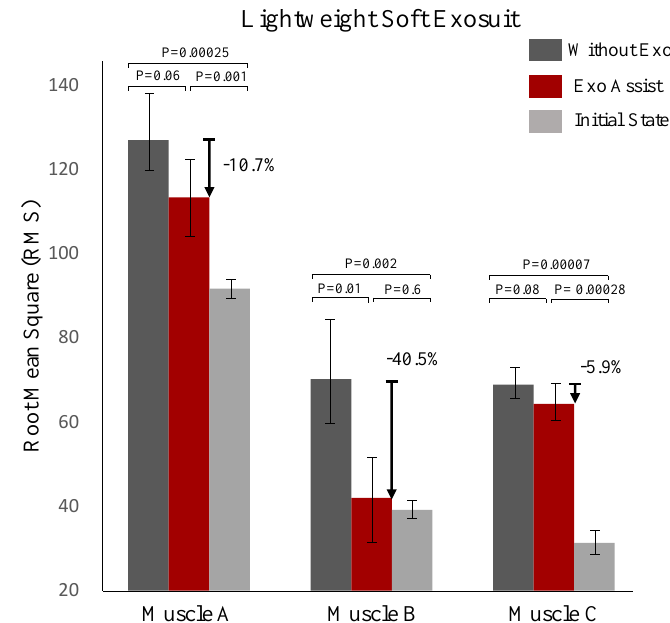
Figure 10. Muscle fatigue degree which uses sEMG to obtain. Muscle A, B and C represent the rectus femoris, vastus lateralis and gastrocnemius, respectively. Exo Assist and Without Exo represent using the lightweight soft exosuit to do muscle fatigue degree experiments through wearing the exosuit with power and without using the exosuit respectively. Initial State represents the initial muscle fatigue degree before